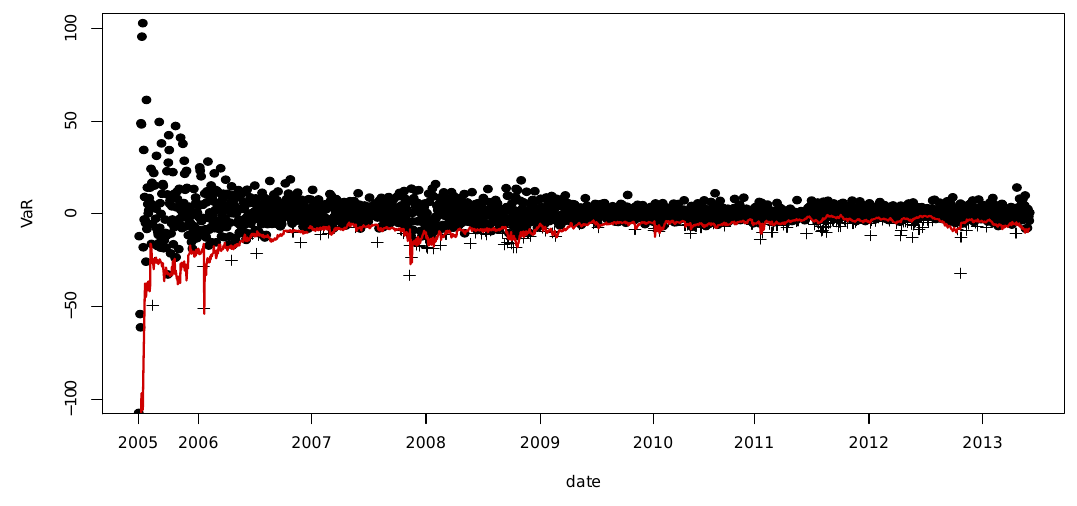
Figure 2: Exceedances plot for VaR ( α ) with α = 0.05 on the IBM-Google portfolio for the DCC model. The dots represent the empirical portfolio value stated by the data, the “+” signs correspond to the exceedances.